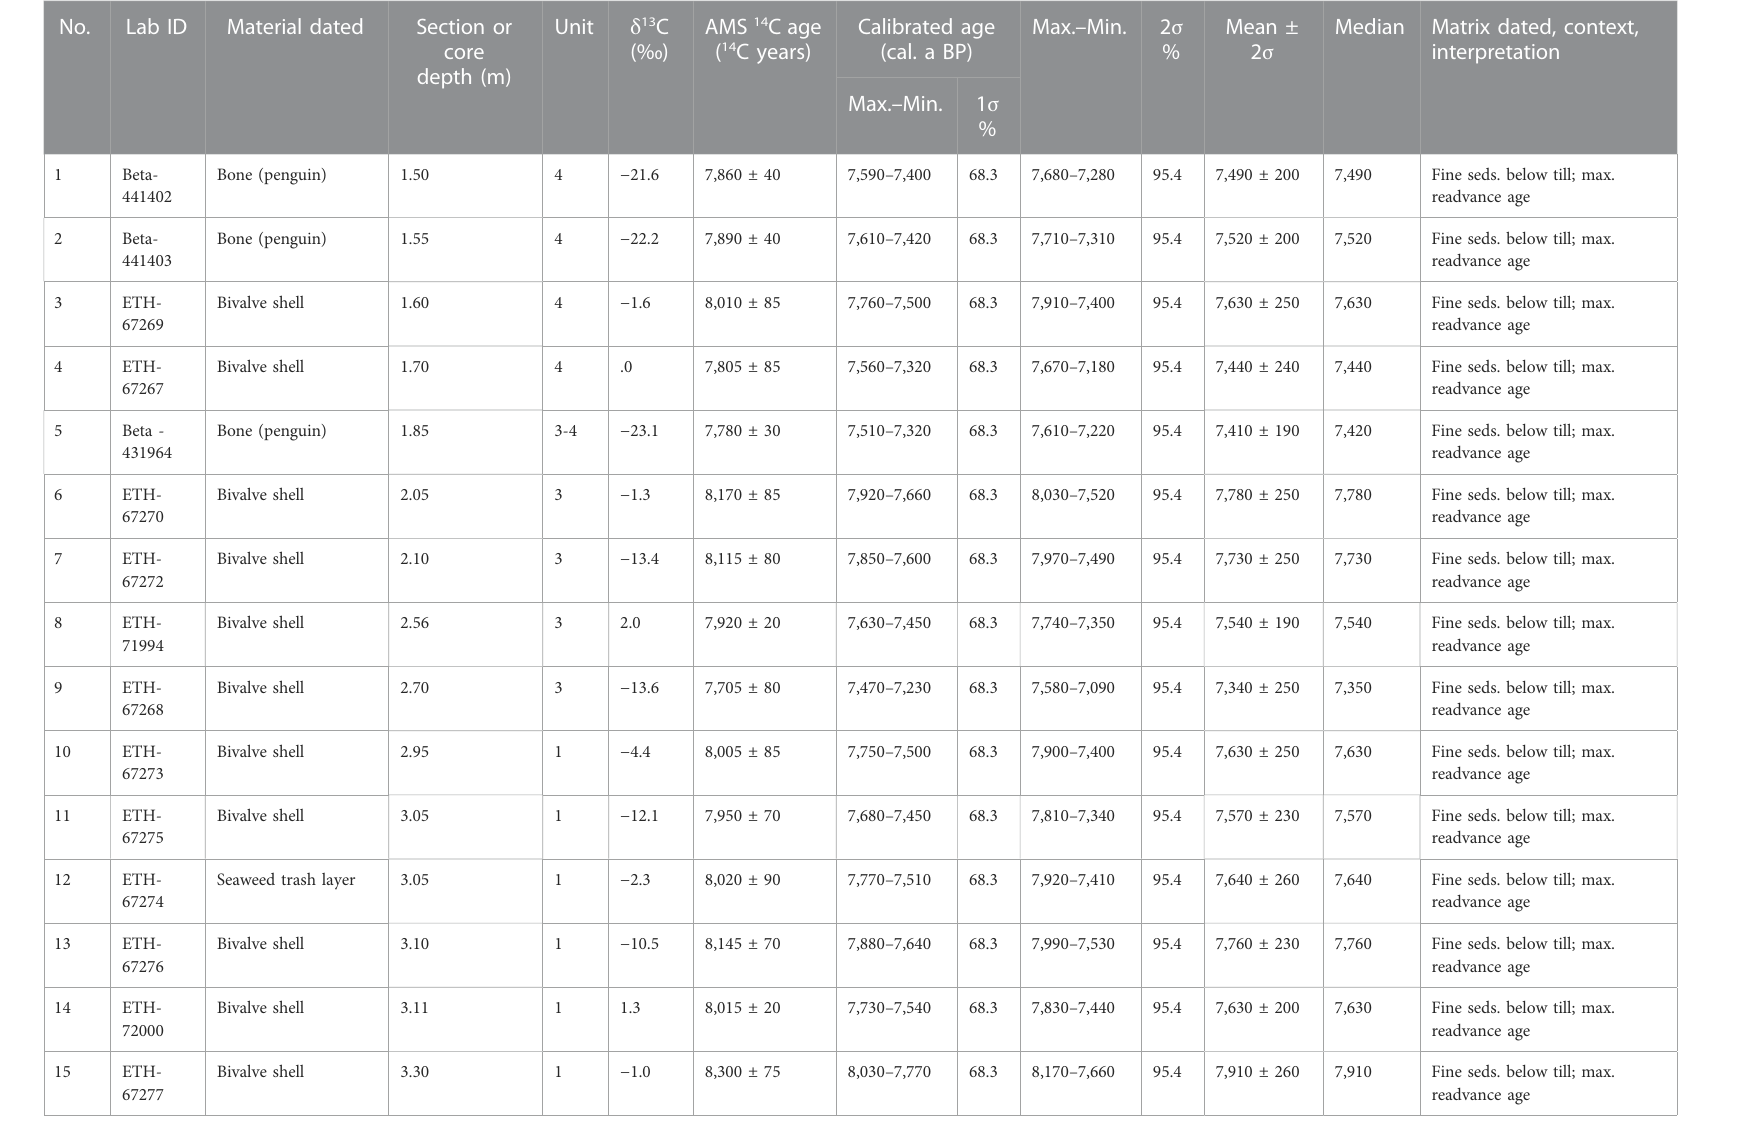
TABLE 2 Radiocarbon dating results. Samples 1 – 21 are from the new Pingfo II section (62.2389 ° S, 58.6729 ° W), samples 22 – 25 from the new “ Potter Cove ” section (62.23895 ° S, 58.67113 ° W), 26 – 27 from the inland outcrop (62.2473 ° S, 58.6466 ° W), and 28 – 30 from the uppermost freshwater subaquatic moss-dominated Unit 3 in the Lake L15-H16 sediment record (62.2405 ° S, 58.6772 ° W).